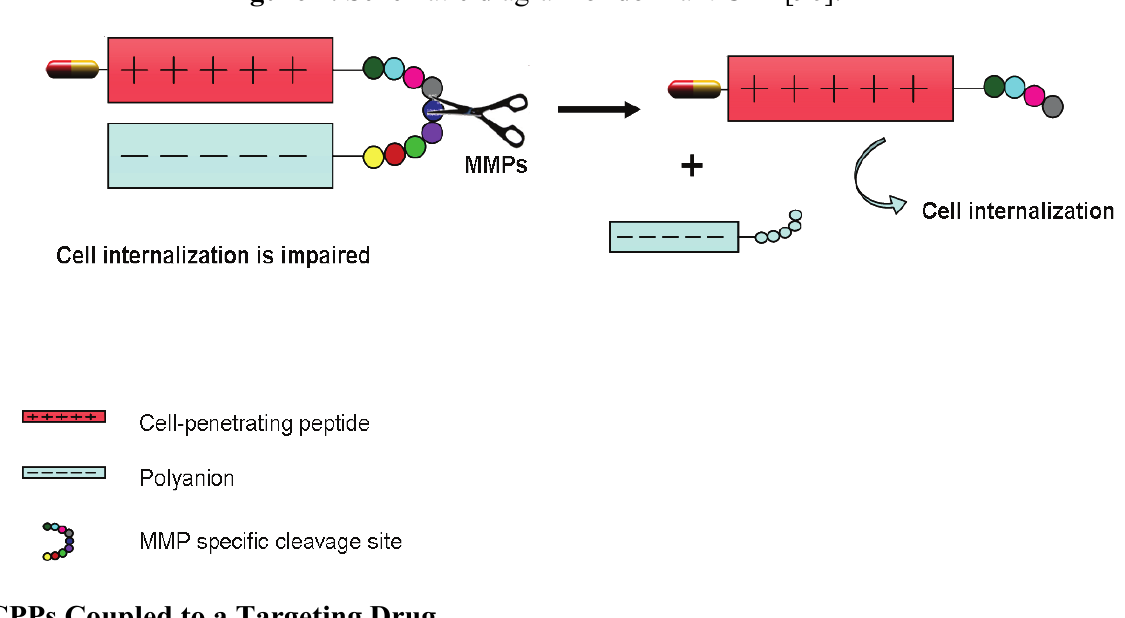
Figure 4. Schematic diagram of dormant CPP